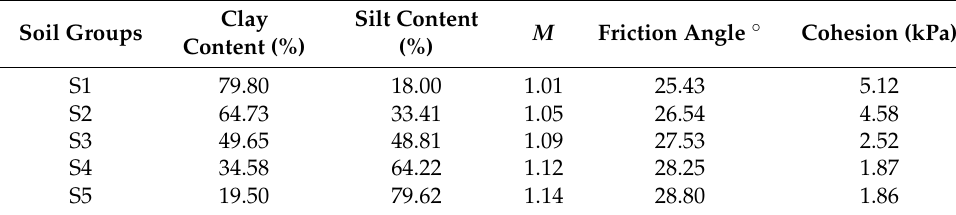
Table 4. Summary of critical state parameters.